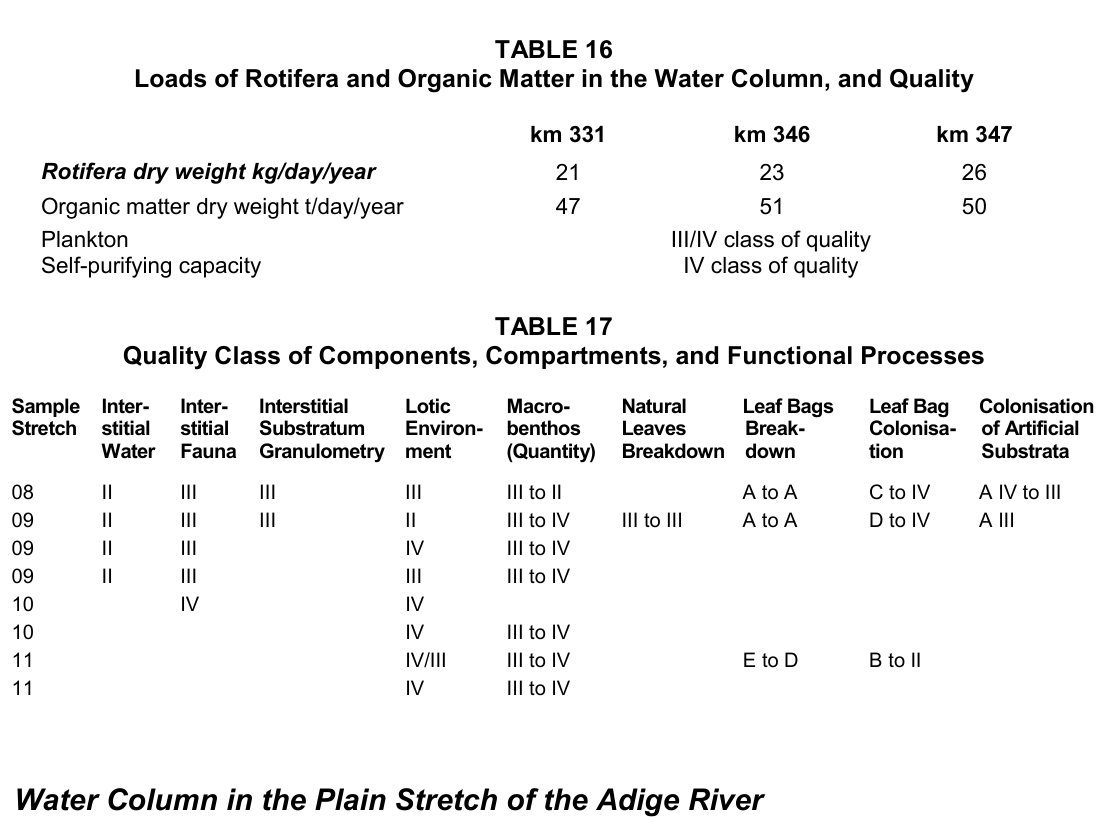
Loads of Rotifera and Organic Matter in the Water Column, and Quality